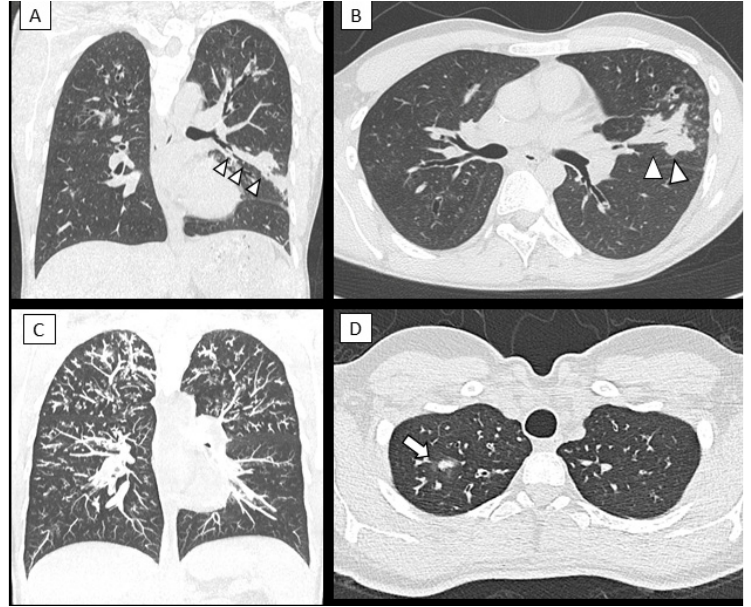
Figure 4. CT findings of mucus plugging: multi-planar reconstruction (MPR) in a coronal ( A ) and axial oblique plane ( B ) of a 17-year-old boy. The “finger in glove sign” (arrowheads) can be seen in the lingual region; this sign is consistent with large airway mucoid impaction, frequently seen in ABPA. Other parenchymal and airway abnormalities are seen in the apical regions of the lungs (cylindrical bronchiectasis and nodular consolidation). Coronal maximum intensity projection-MIP ( C ) and axial plane CT images ( D ) of a 16 year-old female with ABPA shows diffuse branched opacities in the upper lung regions, so called “tree in bud appearance” representing distal airways mucus plugging. Small consolidation in the apical segment of the right upper lobe is also seen (white arrow).